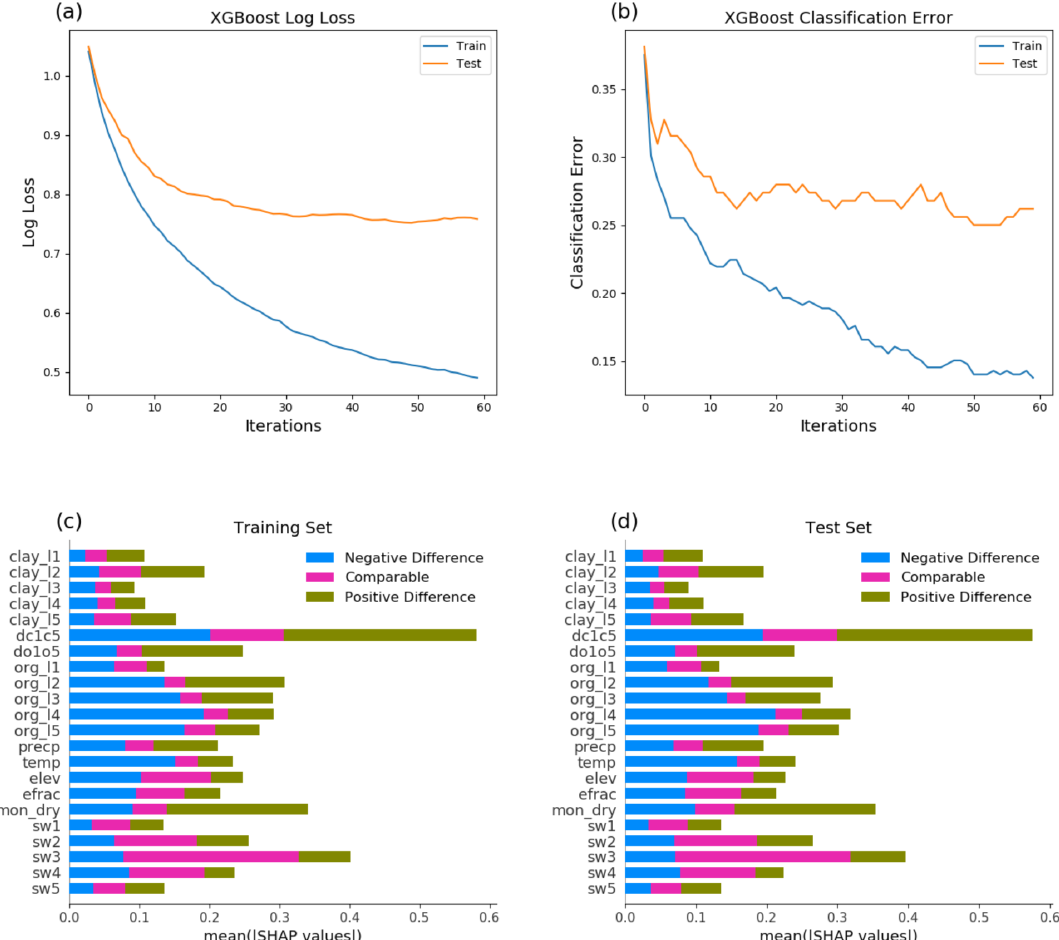
Figure 5. XGBoost model evaluation using selected conditions as predictors: learning curve, logarithmic loss (a) , learning curve, classifica- tion error (b) , feature importance for the training set (c) , and feature importance for the test set (d)